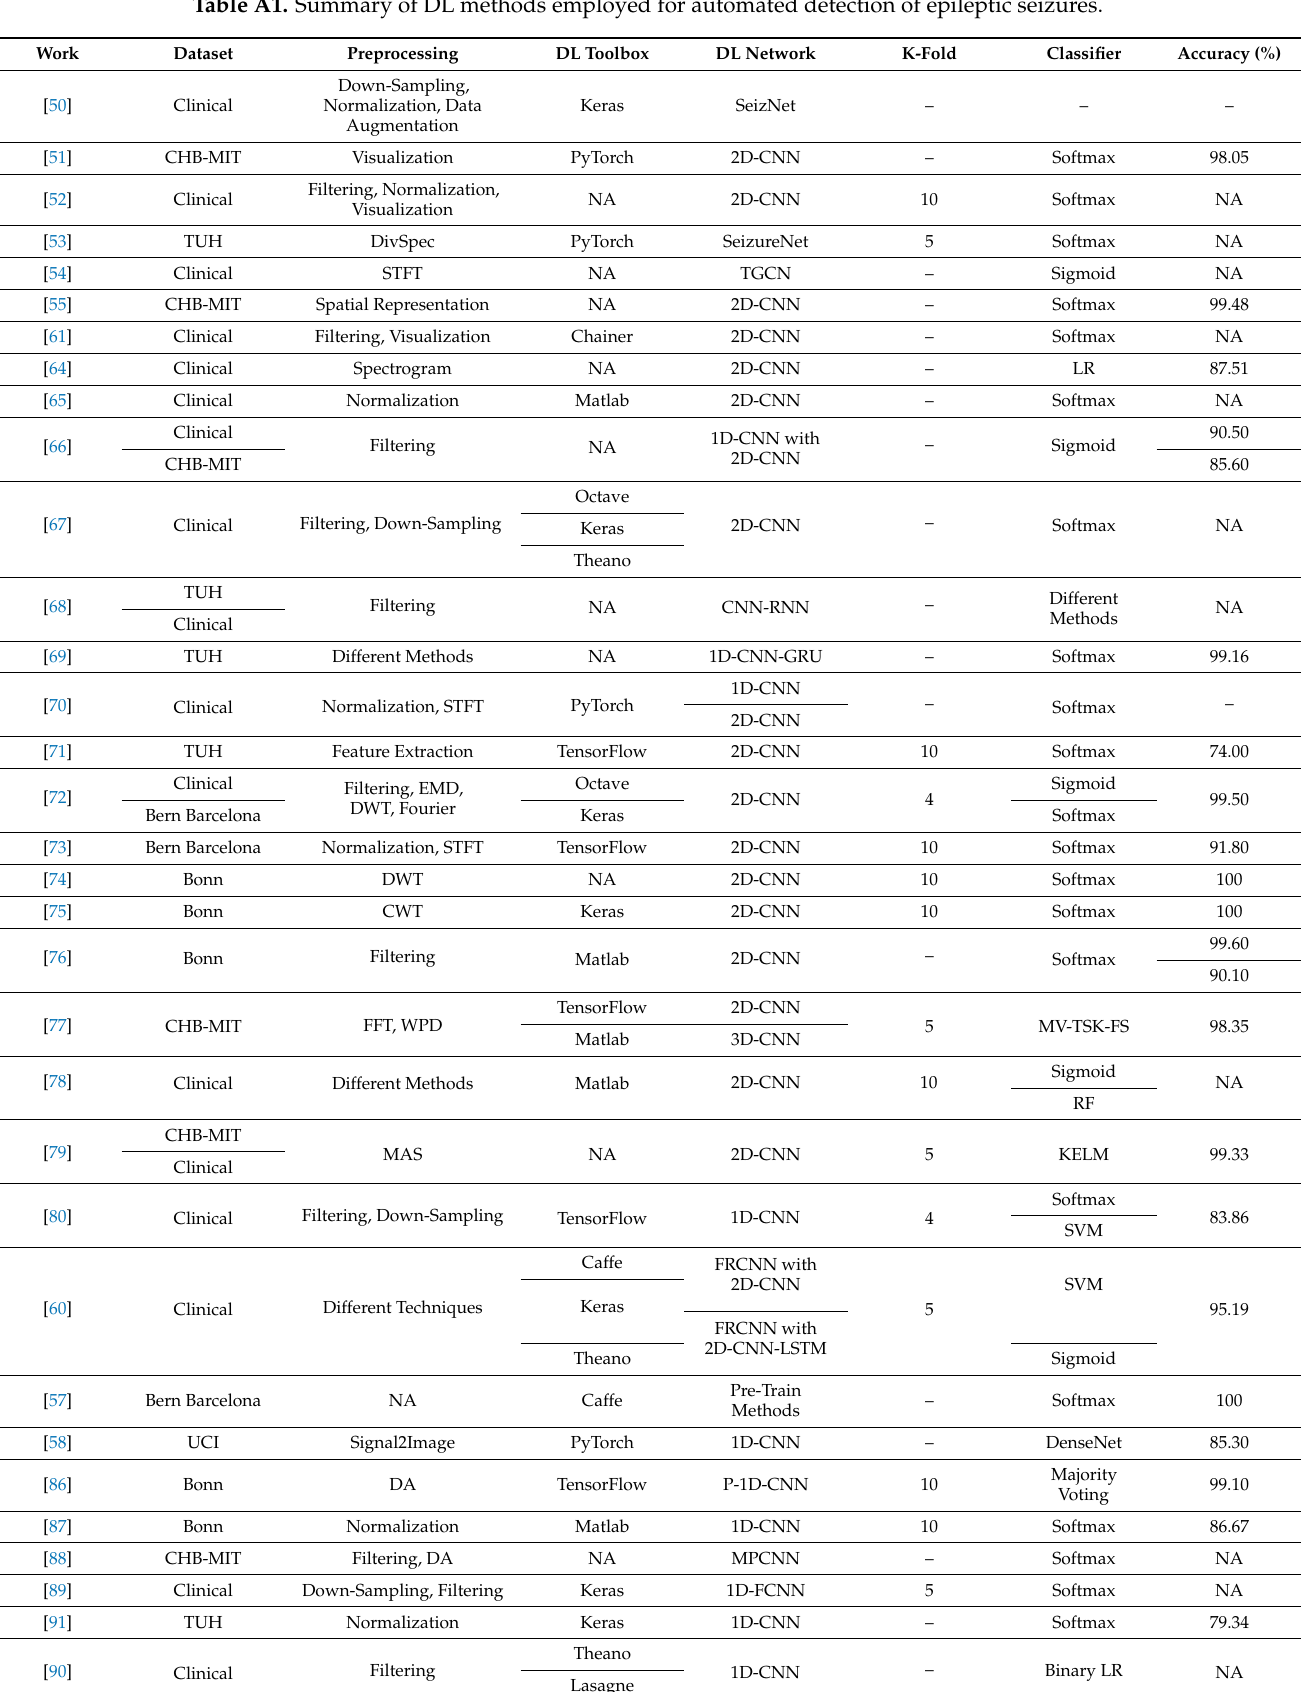
Table A1. Summary of DL methods employed for automated detection of epileptic